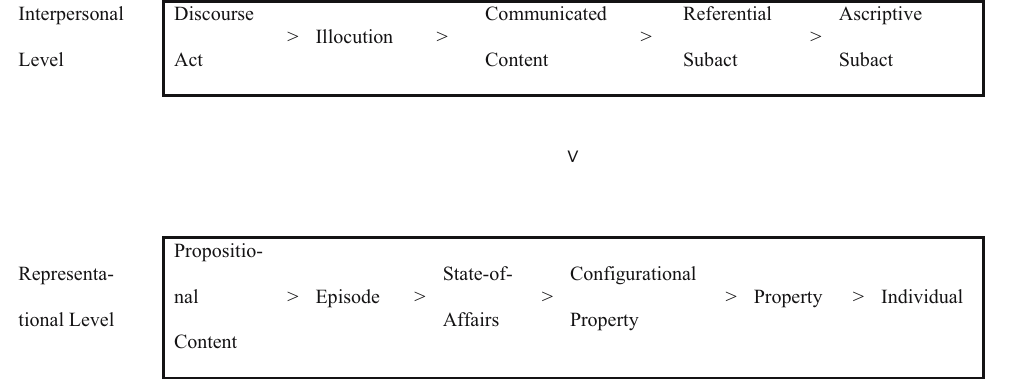
Figure 2: Hierarchical relations at the IL and